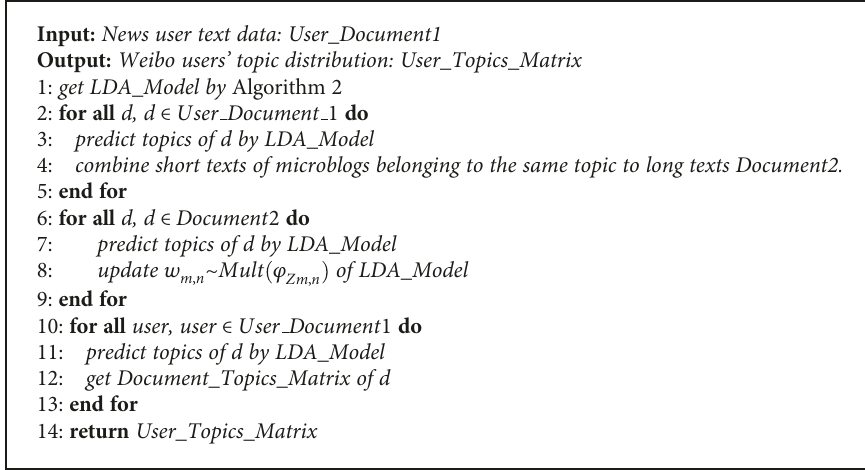
Algorithm 3: Improved LDA topic model based on Weibo